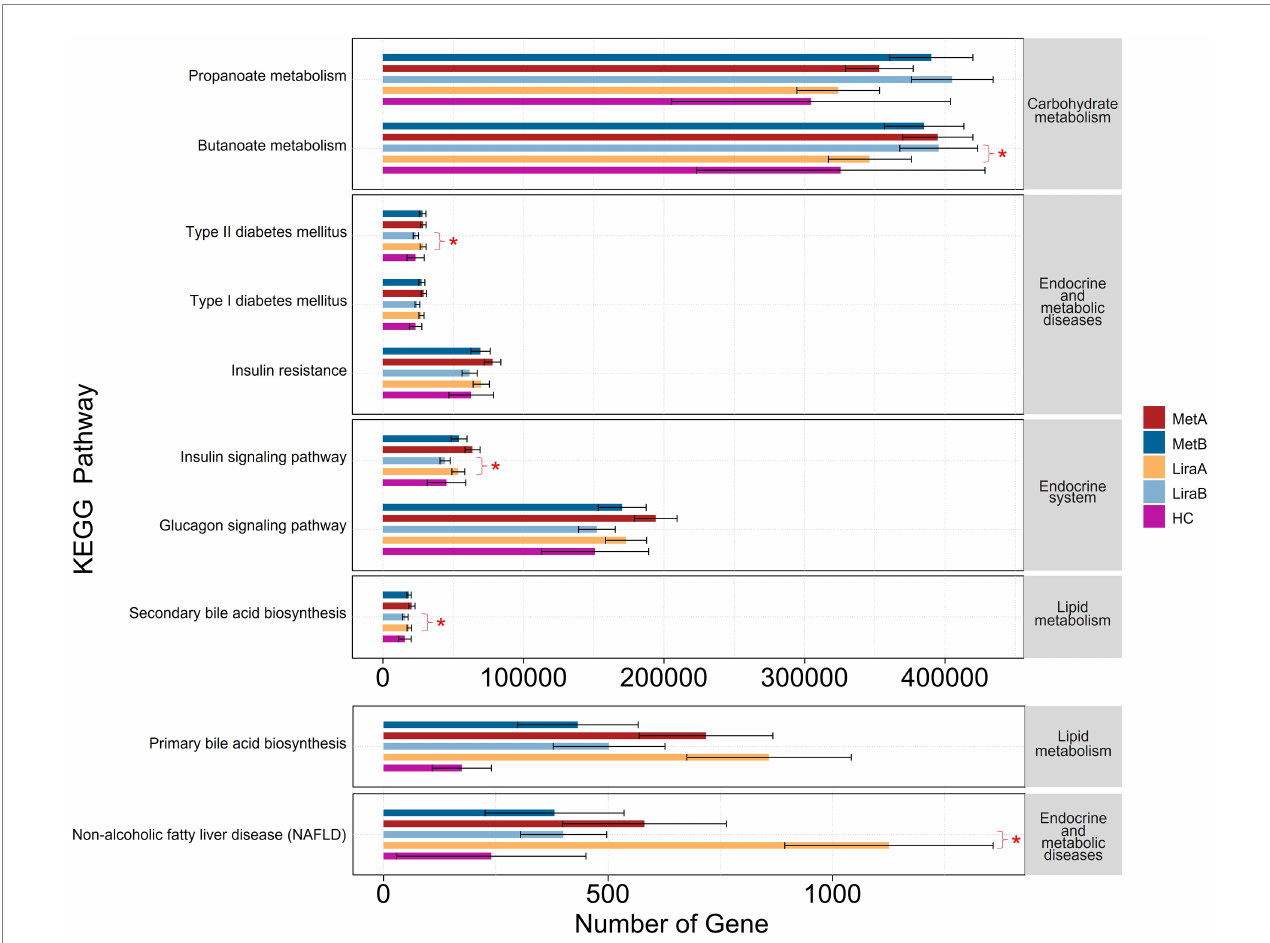
FIGURE 7 Differences in intestinal bacterial community function between healthy controls and patients before and after metformin or liraglutide treatment. “*” indicates significant differences at 0.05 level between the